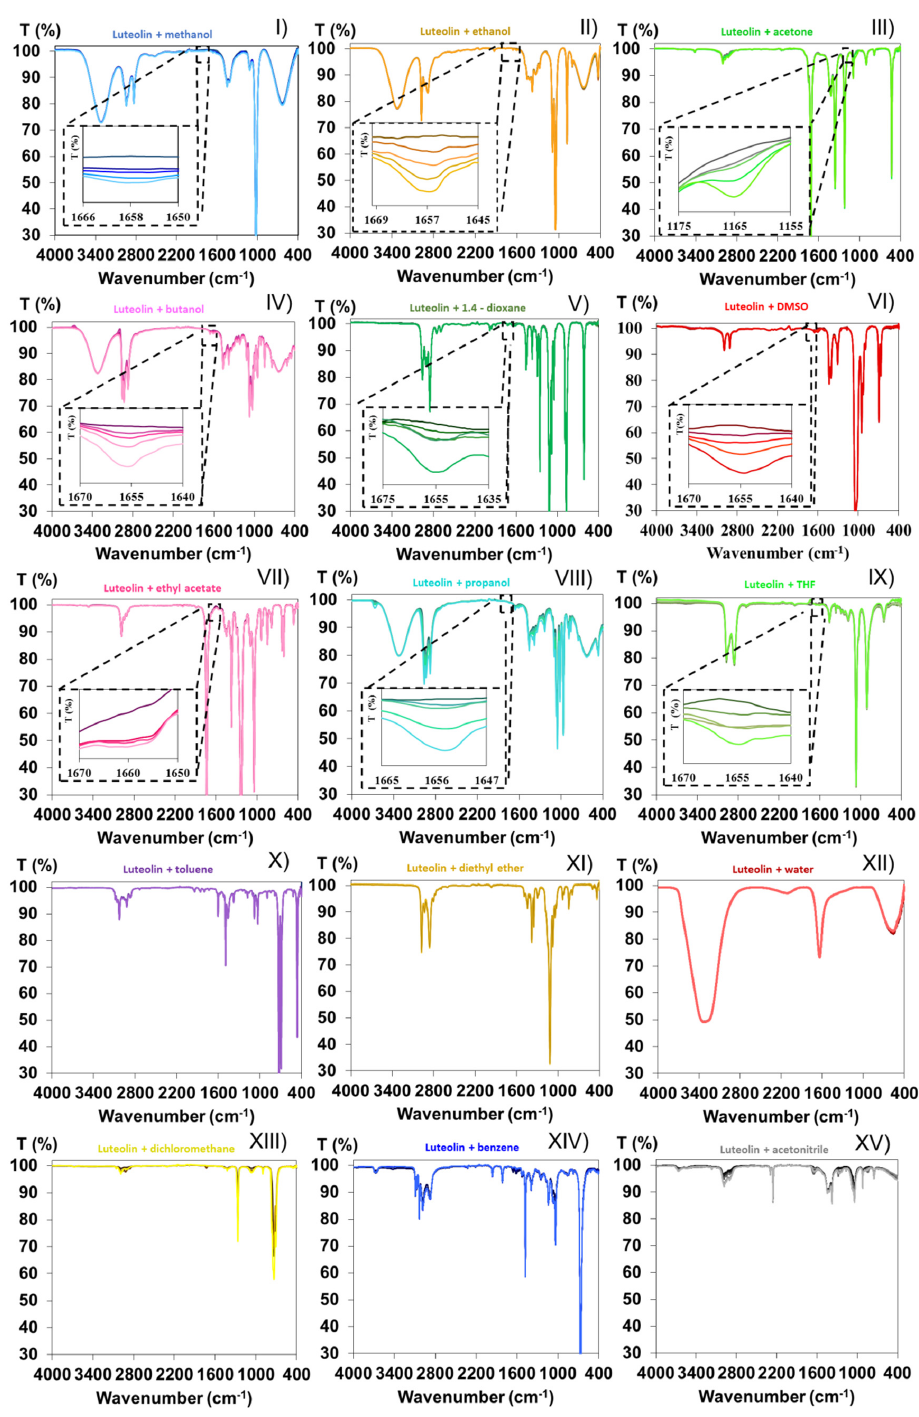
Figure 4. FTIR–ATR spectra of 1, 2, 4 and 8 mg·ml − 1 of luteolin dissolved in various solvents. Spectrum of pure solvent is presented with darker intensity, while the spectrum of luteolin dissolved in solvent has a lighter intensity with the color intensity increasing with luteolin concentration: ( I ) methanol, ( II ) ethanol, ( III ) acetone, ( IV ) butanol, ( V ) 1,4-dioxane, ( VI ) DMSO, ( VII ) ethyl acetate, ( VIII ) propanol, ( IX ) THF, ( X ) toluene, ( XI ) diethyl ether, ( XII ) water, ( XIII ) dichloromethane, ( XIV ) benzene and ( XV )